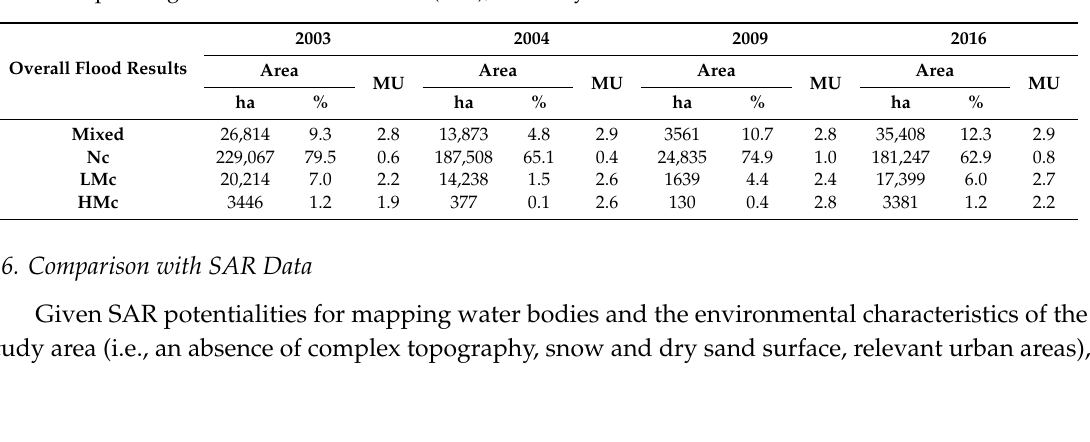
Figure 8. Overall flood maps obtained with MINDED, for each selected event (the corresponding NIR band of t2 is displayed in grayscale as the background of Nc pixels) within both the study area and ROI (Coordinate System: PT-TM06/ ETRS89). Table 8. Overall flood map results for the whole study area in terms of extent (ha and %) and corresponding class mean uncertainties (MU), for every selected